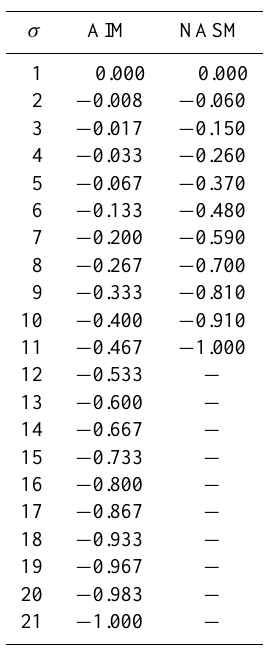
Table 3. Sigma layers distribution in AIM and